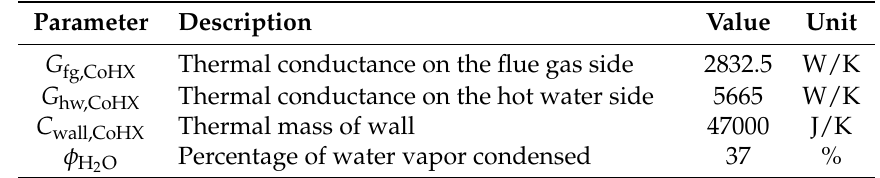
Table 5. Parameters of the CoHX grey box